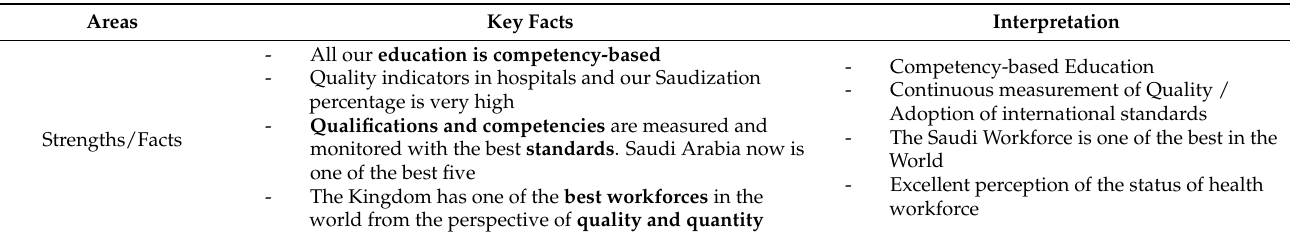
Table 2. Workforce Competency